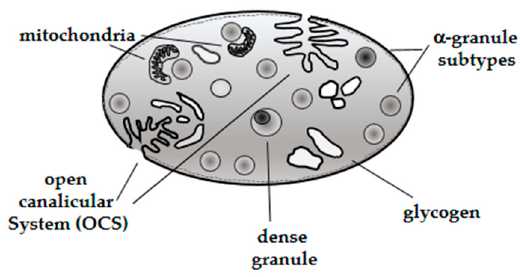
Figure 1. Schematic diagram of a dog platelet.